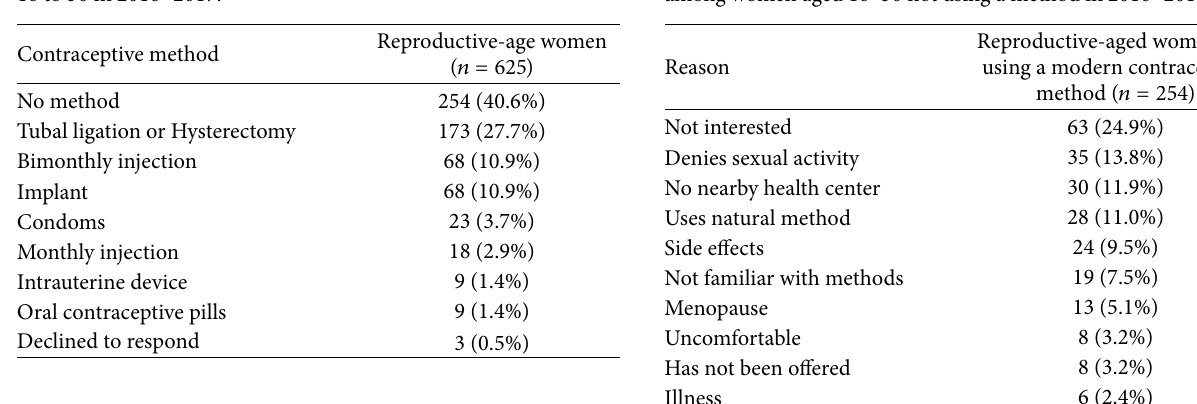
Table 2: Primary reason for not using modern contraceptive methods among women aged 16–50 not using a method in